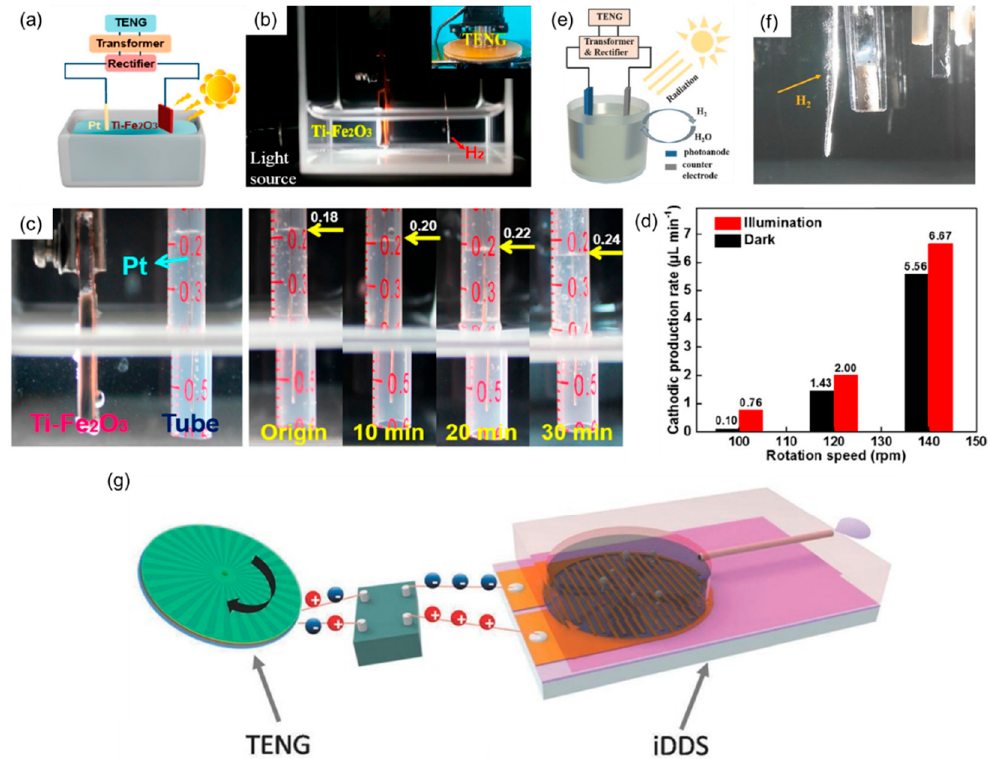
Figure 9. ( a ) Schematics of the triboelectric nanogenerator (TENG)-driven water splitting system and ( b ) digital image. ( c ) Digital images of the gas collection tube at different time. ( d ) Cathodic production rate as a function of rotation speeds to generate currents and potentials from the TENG. ( e ) Schematics of the TENG-driven photoelectrochemical (PEC) hybrid cell. ( f ) Photograph of water splitting process. ( g ) Schematic illustration of the TENG-driven water splitting for the drug delivery system. ( a – d ) Reproduced from [90], Copyright 2018, American Chemical Society. ( e , f ) Reproduced from [92], Copyright 2017, Wiley-VCH Verlag GmbH & Co. KGaA, Weinheim. ( g ) Reproduced from [94], Copyright 2017, Wiley-VCH Verlag GmbH & Co. KGaA,